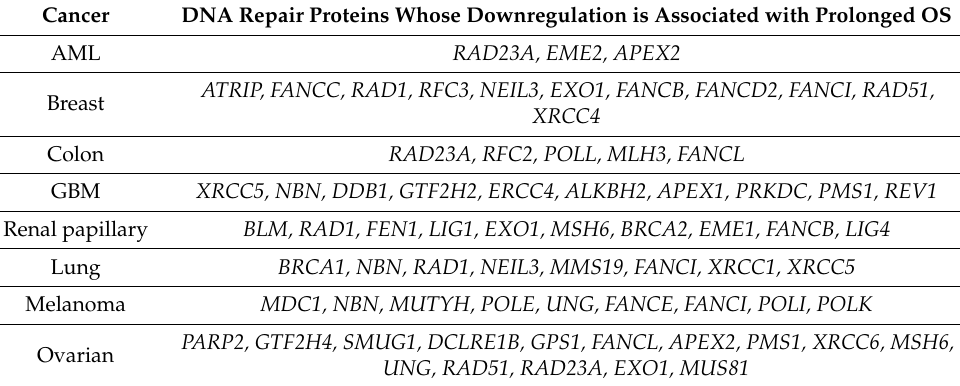
Table 1. DNA Repair proteins employed in ligand-receptor docking